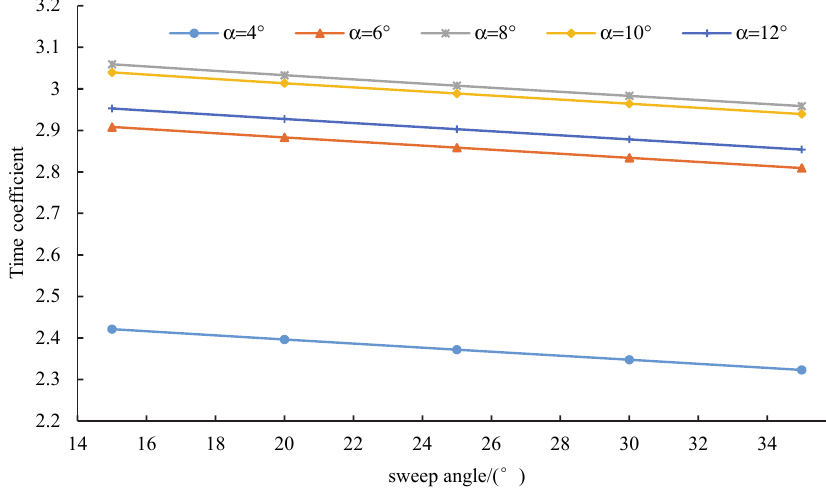
Figure 13. Relationship between the sweep angle and time coefficient.